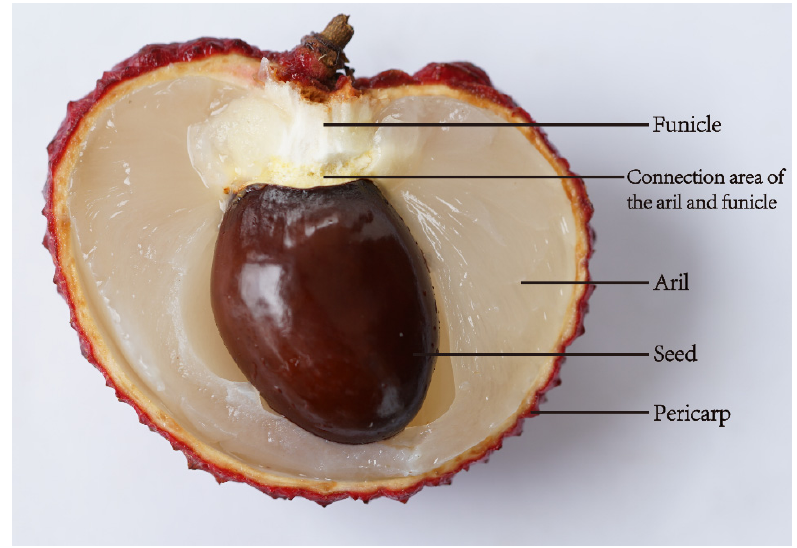
Figure 2. Structure of litchi